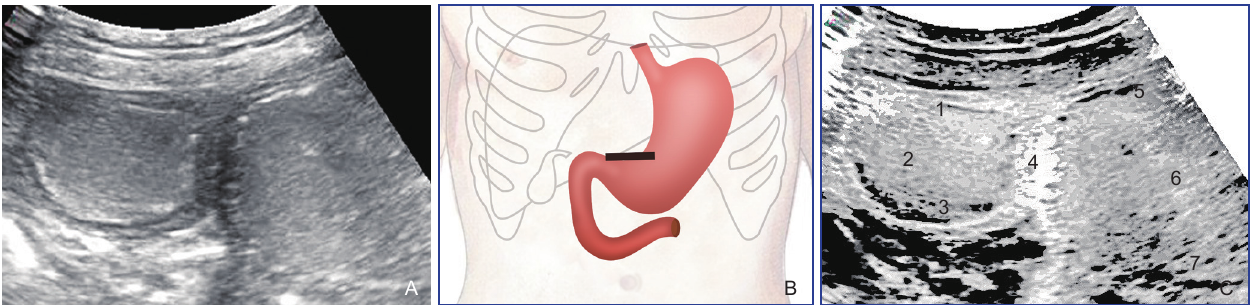
Figure 9 Ultrasonogram and schematic diagram of the long axial section of the gastric angle (scanning under xiphoid process, Angle notch horizontal). A, Ultrasonogram; B, Schematic diagram; C, Schematic diagram of ultrasound (1, Anterior wall of gastric antrum; 2, Gastric antrum; 3, Posterior wall of gastric antrum; 4, The stomach angle; 5, Anterior wall of the stomach; 6, The gastric body; 7, The posterior wall of the